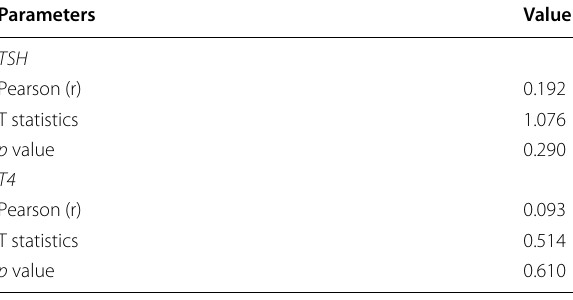
Table 4 Correlation of SWE with TSH and T4 in AIT